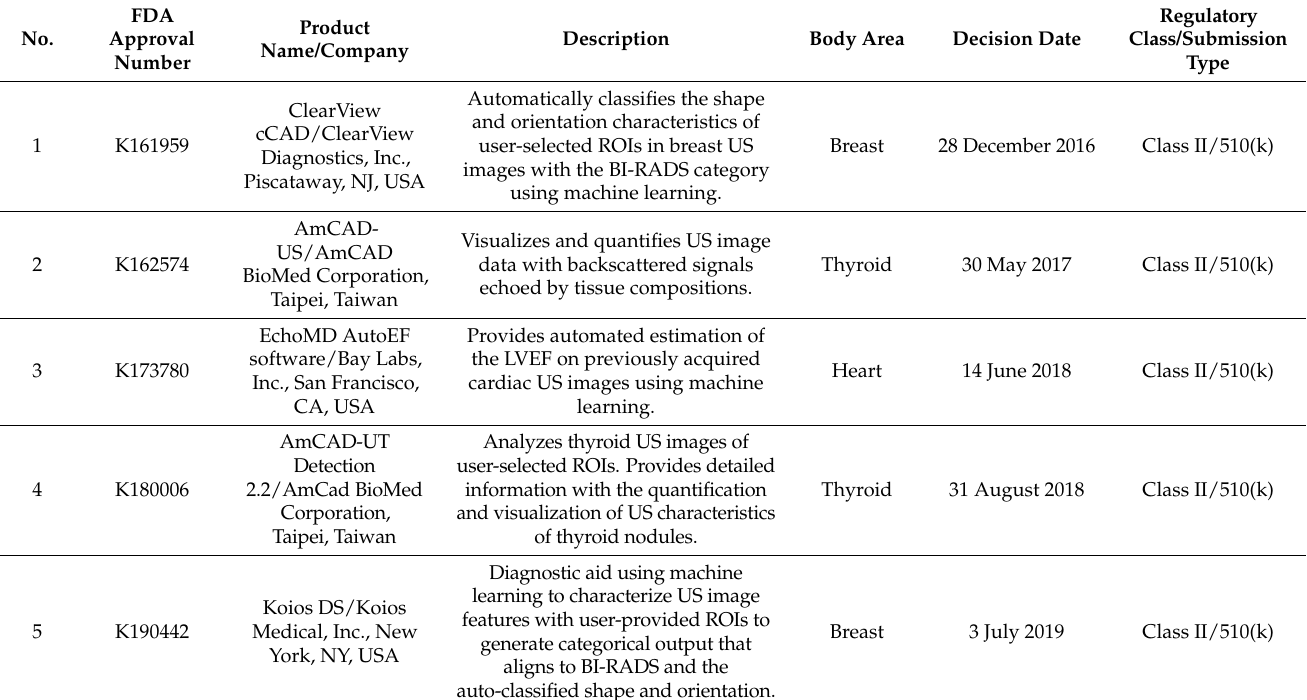
Table 1. List of FDA-approved medical AI devices for US